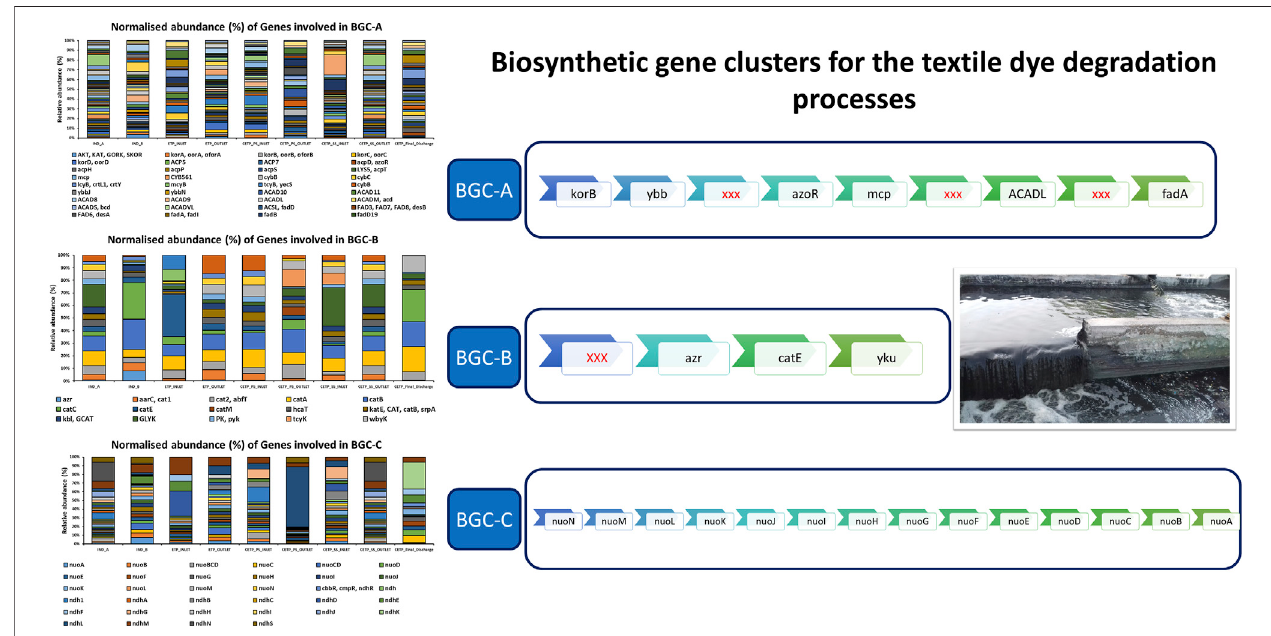
FIGURE8| Relativeabundance(%)ofthegeneinvolvedinthebiosyntheticgeneclusters(BGCs)involvedinthedegradationofthearomaticcompounds,synthetic dyes, and pigments.